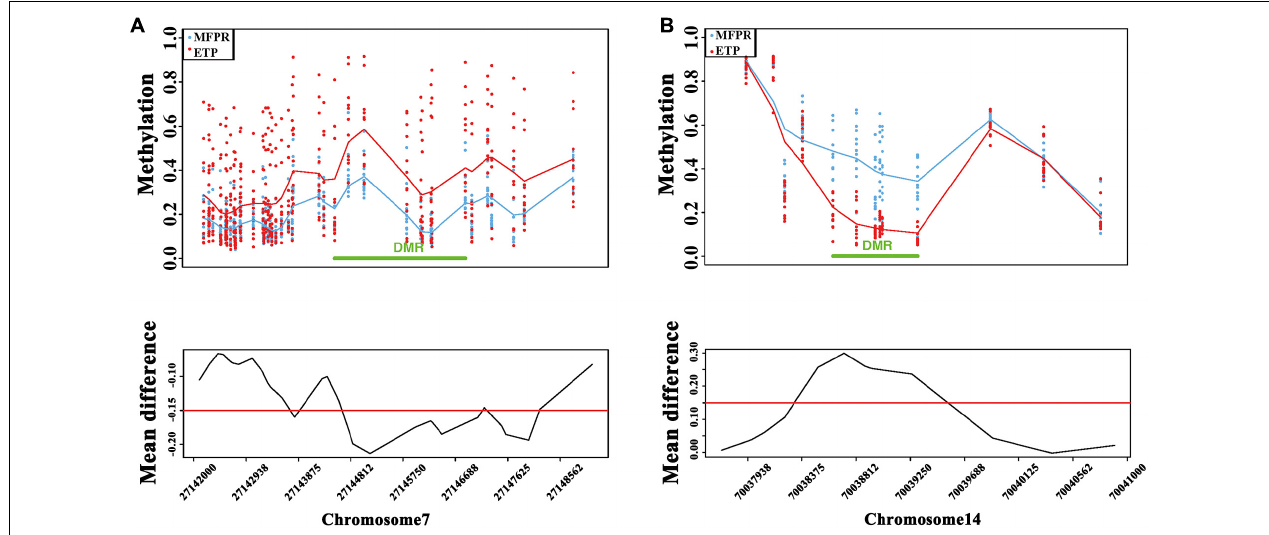
FIGURE 4 | DMR bumphunter analysis. (A) Scatter plots of DMRs and the mean difference (cutoff value = 0.15) between ETP controls (red) vs. the MFPR group (blue) at chr7: 27142000–27148562. (B) Scatter plots of DMRs and the mean difference (cutoff value = 0.15) between ETP controls (red) vs. the MFPR group (blue) at chr14: